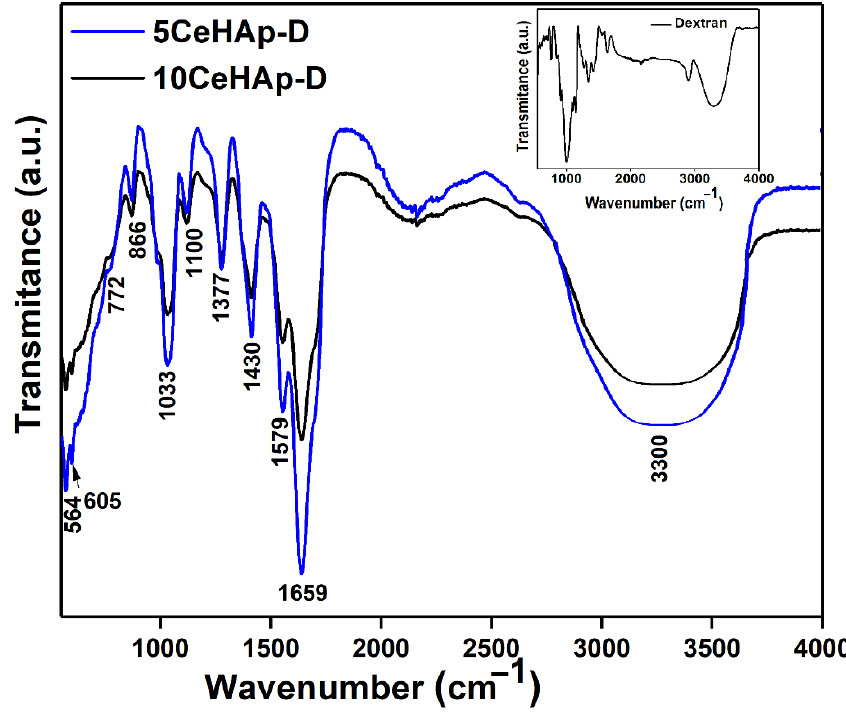
Figure 10. FTIR spectra of 5CeHAp − D and 10CeHAp − D composite thin films. The FTIR spectra of dextran is presented in the inset.